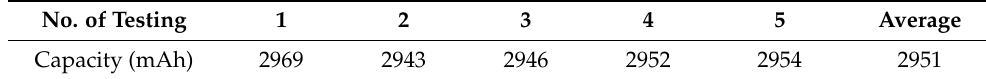
Table 2. Capacity Table 2. Capacity test.